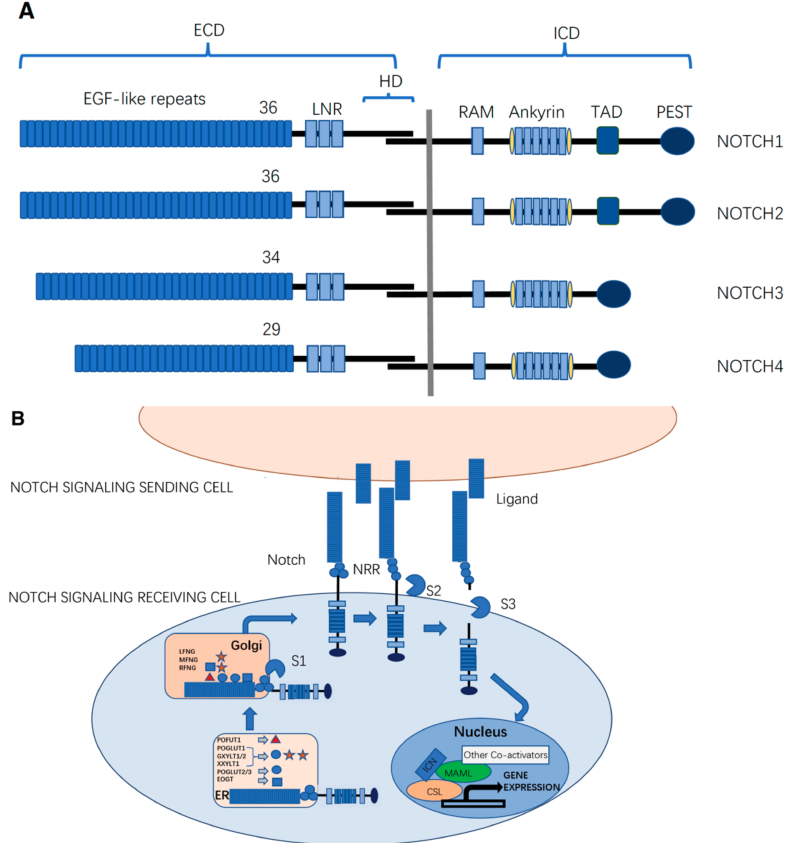
Figure 1. Notch receptors and components of the Notch signaling pathway. ( A ) Molecular structures of Notch receptors. Mammals possess four Notch receptors (NOTCH1–4), The Notch extracellular domain (NECD) contains 29–36 epidermal growth factor-like (EGF) repeats (36 in NOTCH1 and NOTCH2, 34 in NOTCH3, and 29 in NOTCH4) that are responsible for ligand binding. Following the EGF repeats, there are three cysteine-rich LIN12-Notch repeats (LNRs) and one heterodimerization do- main (HD) which functions as a negative regulatory region (NRR) that prevents ligand-independent activation of the Notch signaling pathway. The TAD region is found in Notch1 and Notch2, but not in Notch3 and Notch4 in mammals. ( B ) Notch signaling pathway and its activation. Following proper glycosylation in the endoplasmic reticulum (ER) and Golgi apparatus, NECD is proteolyti- cally cleaved by a furin-like convertase at site 1 (S1 cleavage), and the functional Notch receptor is expressed on the cell surface as a non-covalently associated heterodimer, consisting of the extracellu- lar domain (ECD) and transmembrane domain followed by the intracellular domain (ICD). Upon reaching the cell surface, the ECDs of Notch receptors from the signal-receiving cell interact with the ligands from the neighboring signal-sending cell. This interaction is followed by the endocytosis of the trans-ligand on the signal-sending cell. The endocytosis of the ligand on the signal-sending cell generates a pulling force that induces a conformational change in the NRR, exposing the S2 cleavage site. A disintegrin and metalloproteinase (ADAM) proteases cleave the S2 site of Notch receptors, followed rapidly by γ -secretase-dependent S3 cleavage, releasing the ICD of Notch receptors (NICD), which is subsequently translocated into the nucleus. In the nucleus, the NICD interacts with the DNA-binding transcriptional factor CBF1/RBPjk/Su(H)/Lag1 (CSL), which recruits the co-activator, mastermind-like (MAML), to form a ternary transcriptional complex to activate the transcription of downstream target